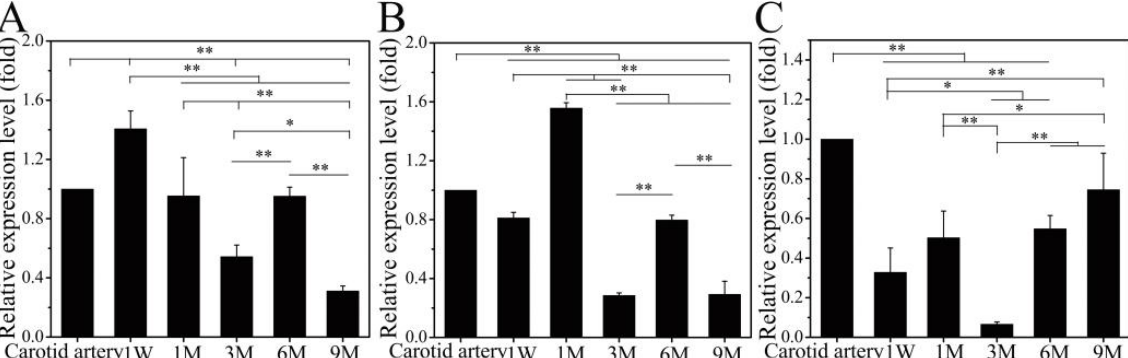
Figure 5. Quantitative analysis of mRNA expression level for elastin ( A ), COL-I ( B ), and COL-III ( C ). Data are presented as mean ± SD, n = 3. “*” represents p < 0.05; “**” represents p < 0.01.